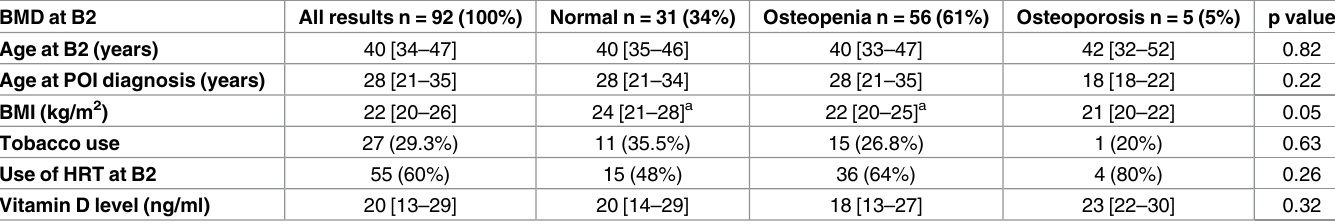
Table 3. Characteristics of POI women with two BMD evaluations, regarding their BMD status at the follow up evaluation. BMD at B2 All results n = 92 (100%)